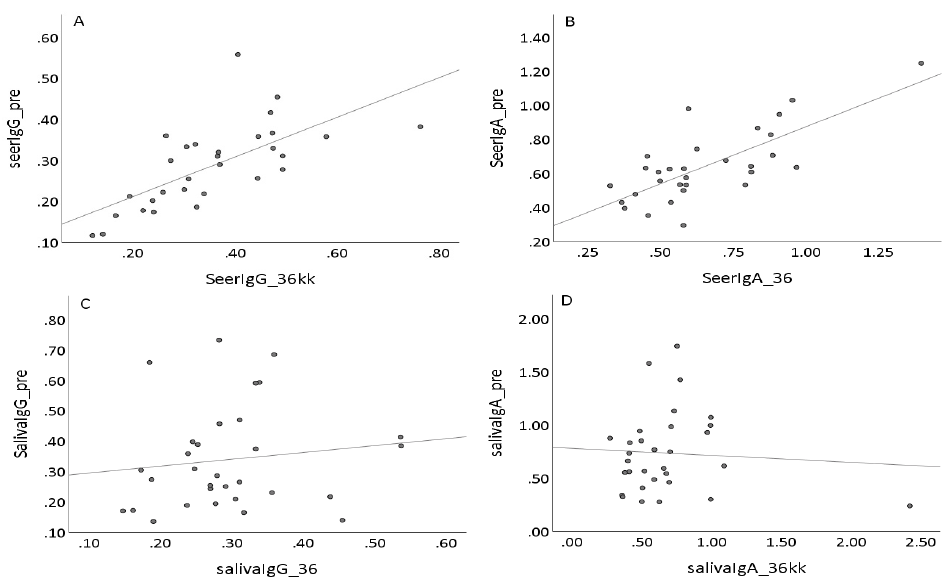
Figure 3. Correlation of serum anti-HPV16L1 IgG ( A ), anti-HPV16L1 IgA ( B ), saliva anti-HPV16L1 IgG ( C ), and anti-HPV16L1 IgA ( D ) levels of the same individual at different time points. The Ig values were measured from saliva and serum samples collected during pregnancy and compared to values measured from samples collected 36 months after delivery.